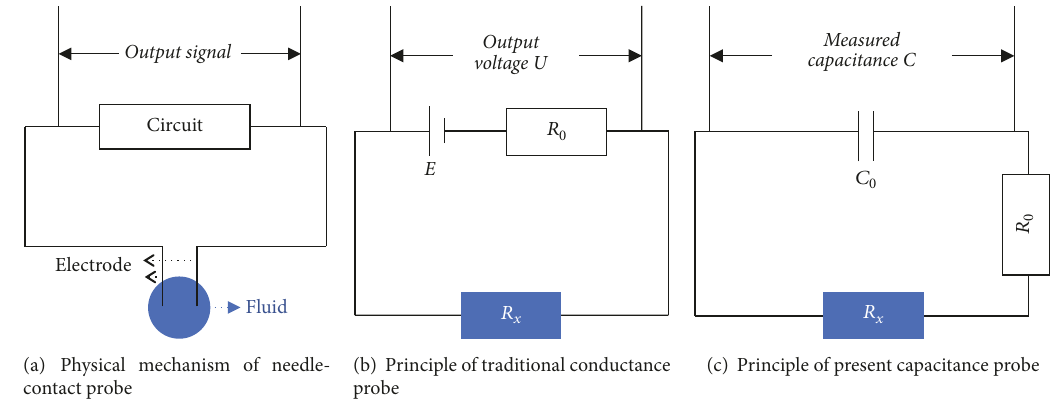
Figure 1: Working principles of needle-contact electrical